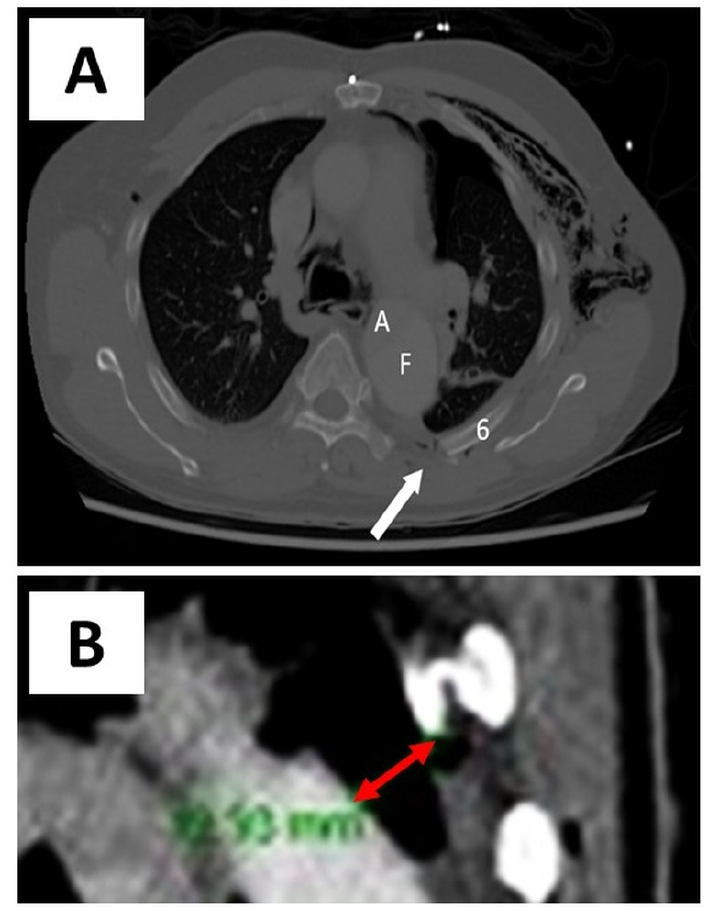
Figure 1. Preoperative chest CT. ( A ). Axial view—preoperative chest CT demonstrating the proximity of the fracture site to the aorta. Subcutaneous emphysema is also seen. ( B ). Section of longitudinal view—preoperative chest CT demonstrating the proximity of the fracture site to the false lumen of the aorta (~13 mm as indicated by the double-tipped red arrow). Arrow—fracture site; A—true lumen of aorta; F—false lumen of aorta; 6—sixth rib.